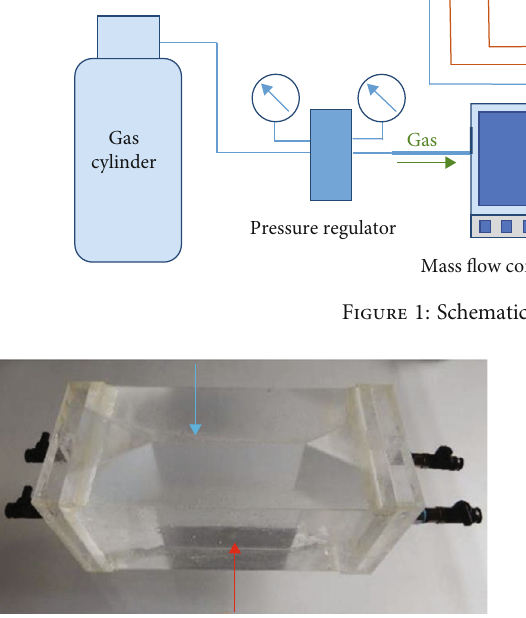
Figure 2: The 3D fracture model [23].